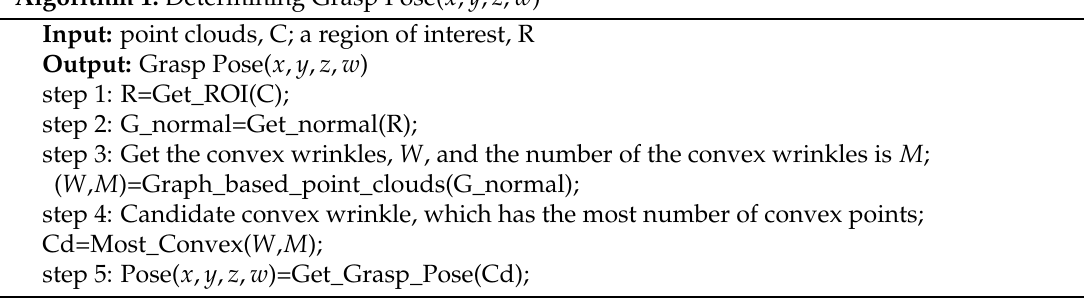
Algorithm 1: Determining Grasp Pose( x , y , z , w